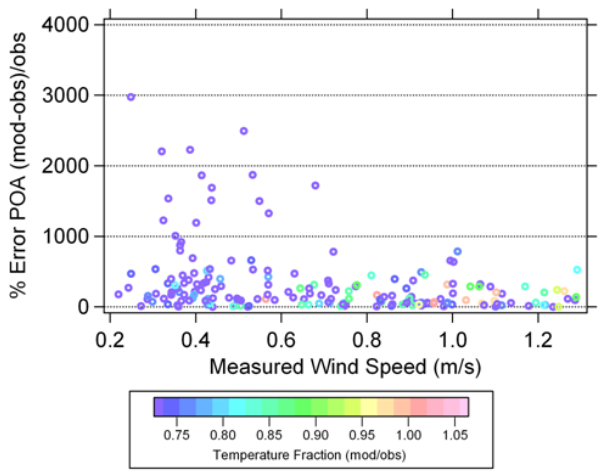
Fig. 4. Model PM 1 POA percentage error for nighttime conditions under low winds at Harrow. The colour coding is the ratio of the modeled and measured surface temperature. Under light winds and cooler model surface temperatures, modelled vertical mixing is di- minished. Data plotted for nights from 29 June to 11 July